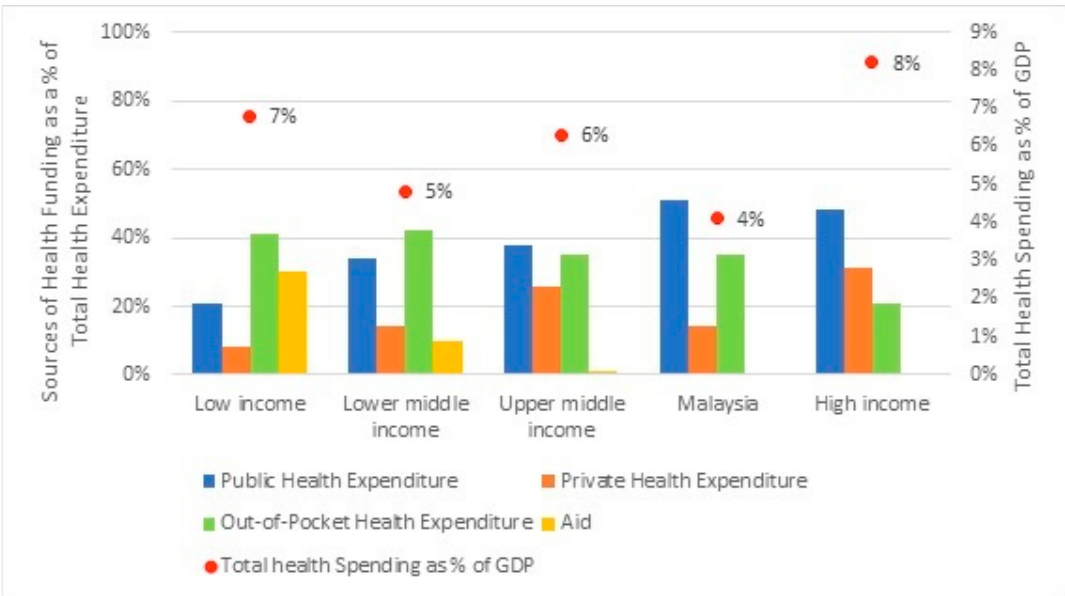
Figure 1. Global health expenditure in 2018. Source: Report on Global Spending on Health 2020: Weathering the Storm (WHO, 2020) and Malaysia National Health Accounts: Health Expenditure Report 1997–2018 (Ministry of Health, 2020).